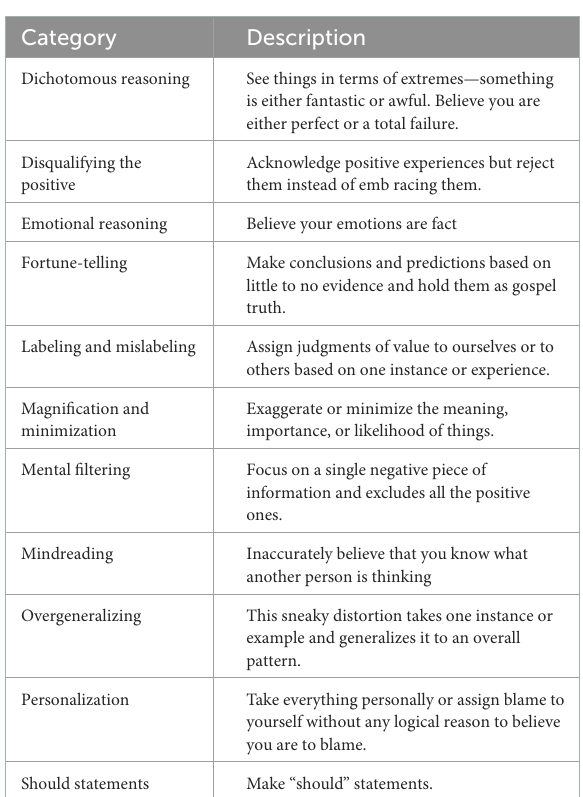
TABLE 3 Main statistics of cognitive distortion dataset.